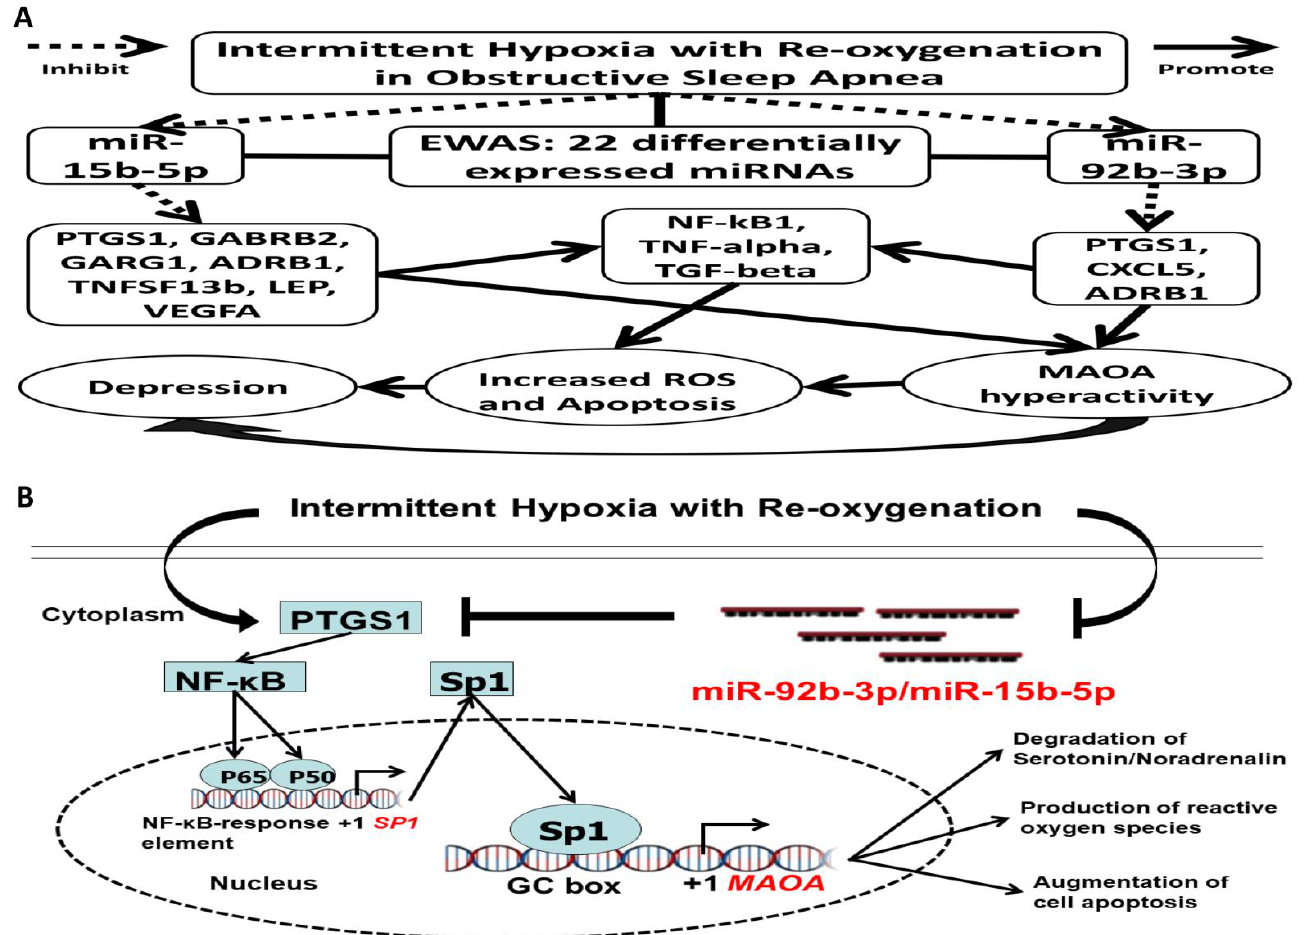
Figure 11. The proposed interplay between miR-15b-5p/miR-92b-3p and their target genes in the intermittent hypoxia with re-oxygenation (IHR) model of obstructive sleep apnea (OSA). ( A ) These interactions contribute to the development of depression by IHR-induced MAOA hyperactivity and IHR-induced oxidative stress/apoptosis/inflammation in OSA patients. ( B ) A schematic diaphragm depicts the protective effect of miR-15b-5p/miR-92b-3p mimics on IHR-induced oxidative stress and cell apoptosis through inhibiting MAOA via targeting PTGS1-NF- κ B-SP1 signaling in OSA-related depression. IHR augments PTGS1, which increases the NF- κ B expression that in turn activates MAOA gene transcription through augmenting the binding of SP1 to the promoter region of the MAOA gene. Down-regulation of miR-15b-5p/miR92b-3p in response to chronic IHR in OSA leads to MAOA hyperactivity, oxidative stress, and cell injury through targeting PTGS1-NF- κB1 -SP1 signaling. MAOA = monoamine oxidase A; PTGS1 = prostaglandin-endoperoxide synthase 1; NF- κB1 = nuclear factor kappa B subunit 1; SP1 = Sp1 transcription factor